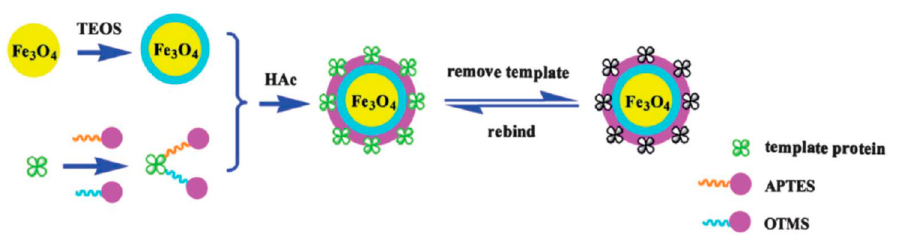
Figure 6. Nano-magnetic MIP preparation with sol-gel [47].